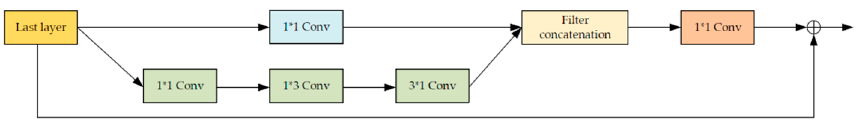
Figure 7. The architecture of the proposed residual-dense-inception block.